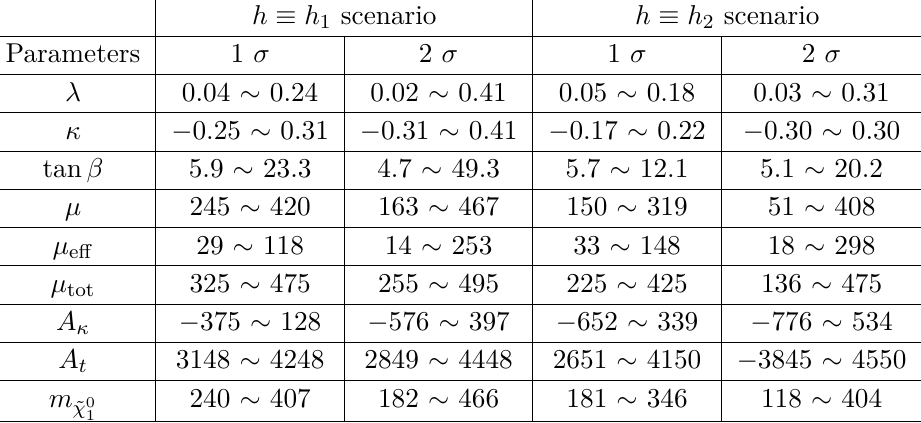
Table 2 . One-dimensional 1 σ and 2 σ credible regions for input parameters in h ≡ h 1 and h ≡ h 2 scenarios, where h , h , and h denote the SM-like Higgs boson and the lightest and next-to-lightest 1 2 CP-even Higgs boson, respectively. Dimensional parameters are in units of GeV.